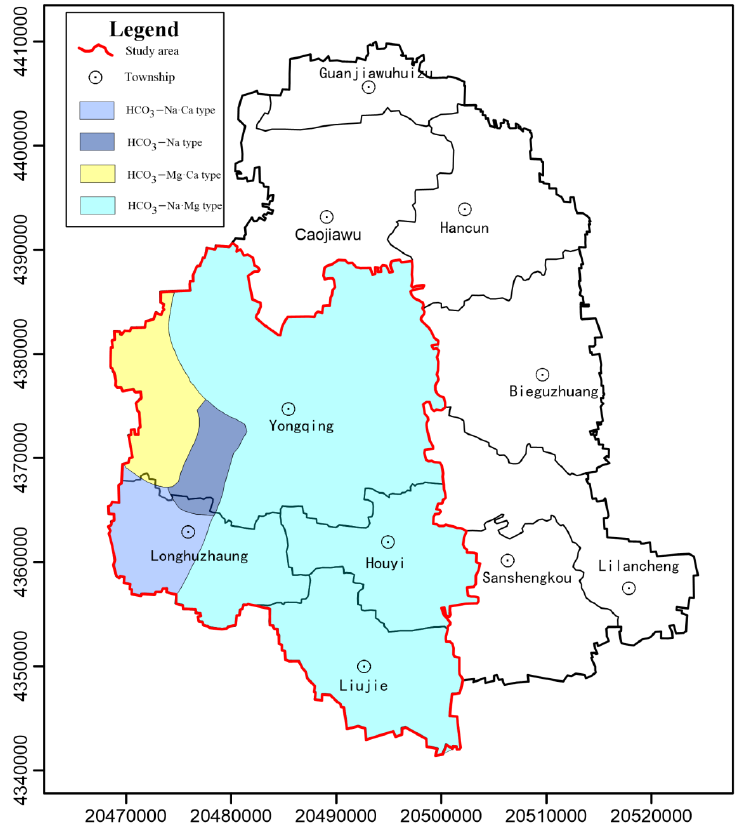
Figure 4. Zoning map of groundwater facies types in the study area.